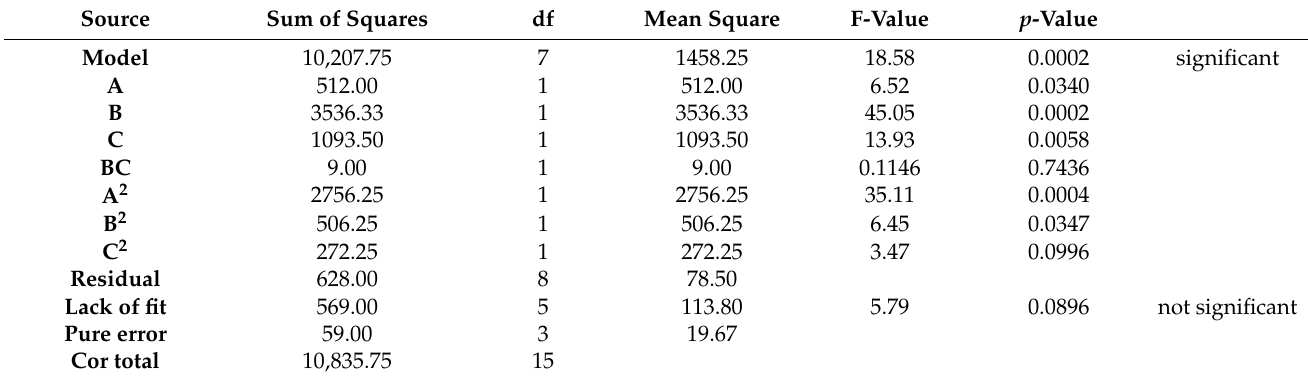
Table 9. ANOVA for the response surface reduced quadratic polynomial model for DCSLM with threshold concentration of Cyanex272.